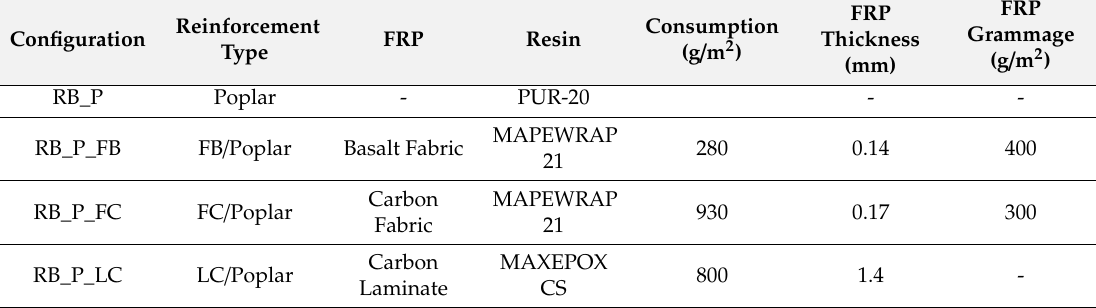
Table 2. Reinforced beams: Nomenclature, types and main FRP